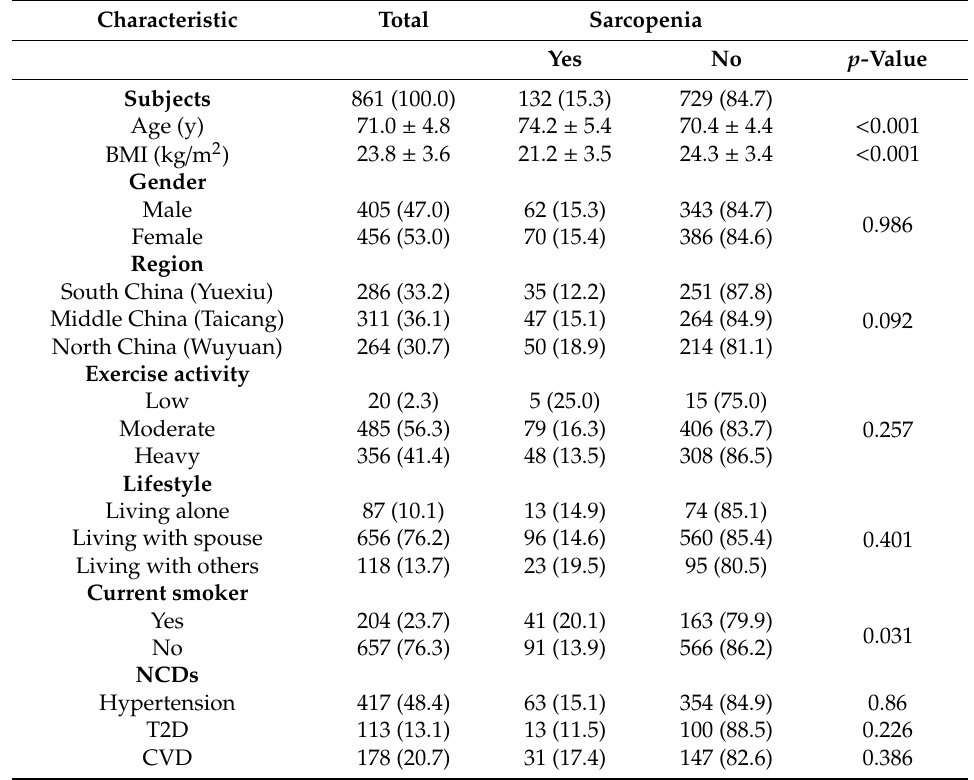
Table 1. Participants